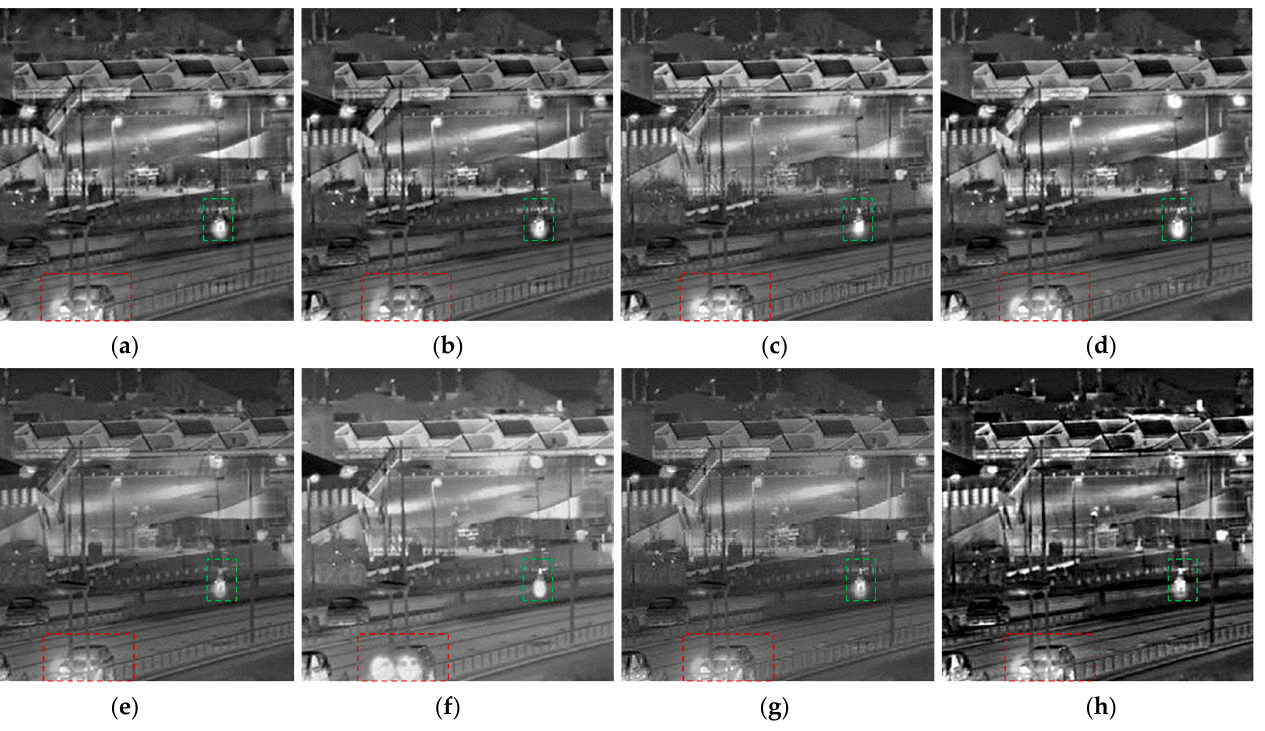
Figure 13. Performance comparison of different fusion methods on the image pair “Road”. ( a – h ) are the results of CVT, CWT, WLS, LP, ADF, GTF, MSVD and our algorithm, respectively. As for the algorithms of CWT, WLS and ADF, the interesting parts such as the vehicles, the person and the lights are not able to be well highlighted. At the same time, the results of GTF and MSVD fusion algorithms do not conform to human eye vision observation due to its blurred details. Furthermore, the image contrast of the CVT and LP methods